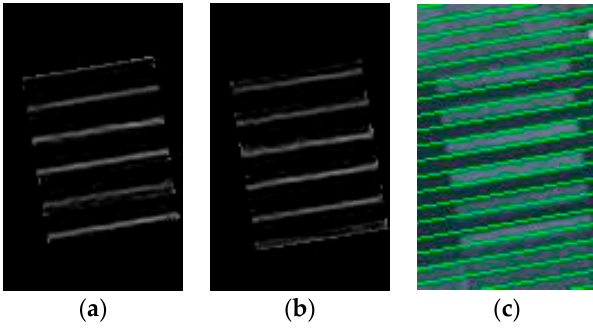
Figure 13. ( a ) The gradient of the edges on one side of the stripe; ( b ) The gradient of edges on the